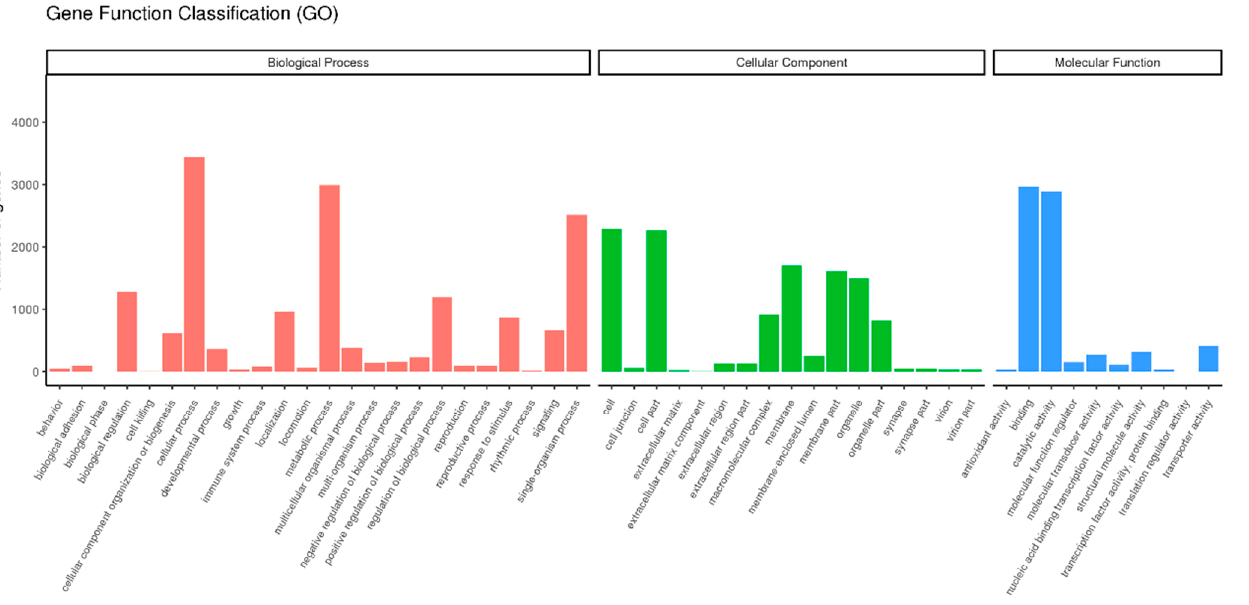
Figure 2. Gene ontology (GO) classification of P. versicolora unigenes.